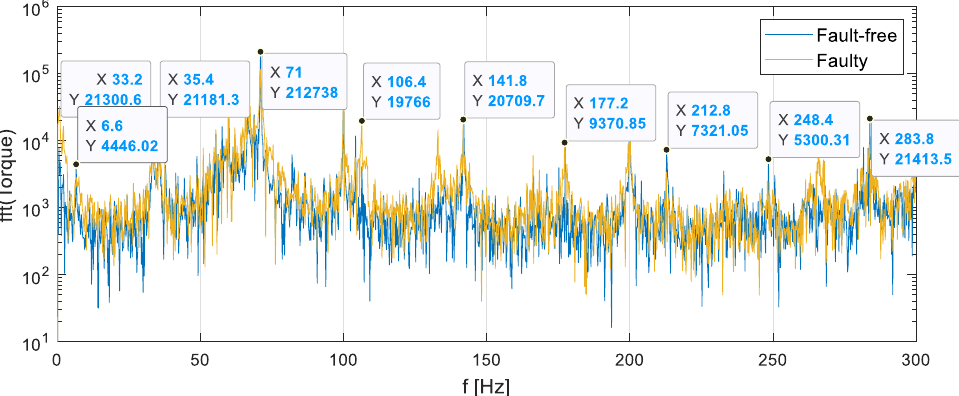
Figure 8. Frequency spectrum of the torque signal of the output shaft at a speed of 2000 rpm and a load of 30 Nm. load of 30